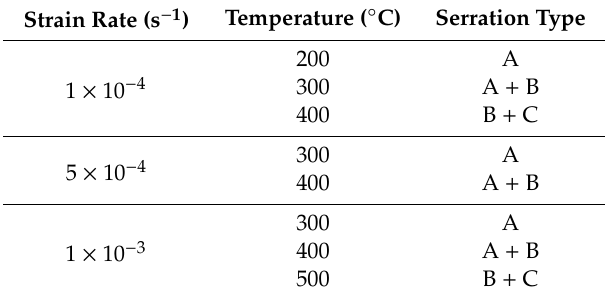
Table 4. Strain rates, test temperatures, and serration types for the Al 0.5 CoCrCuFeNi HEA during tension testing (from Reference [94]).